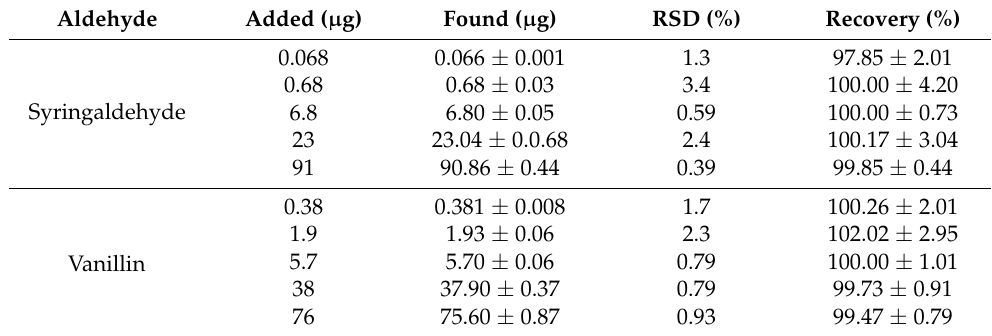
Table 6. Simultaneous quantification of aromatic aldehydes in model mixtures at the poly( p